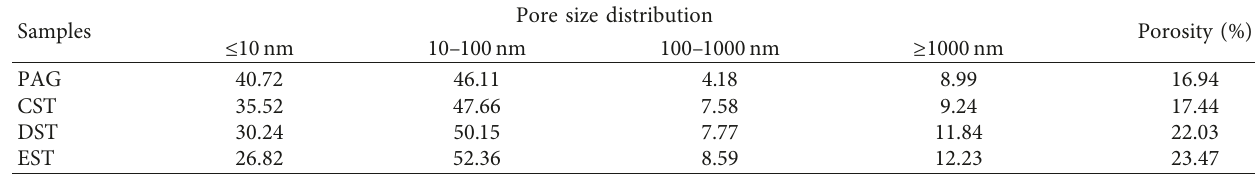
Table 2: Porosity and pore size distribution of PAG-solidified TBP/OK samples